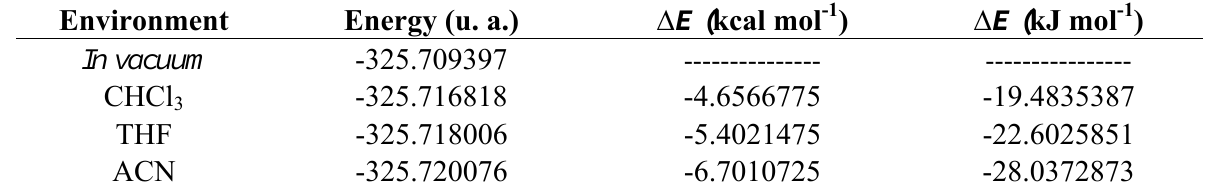
Table 5. Δ E of 4VPy in different solv